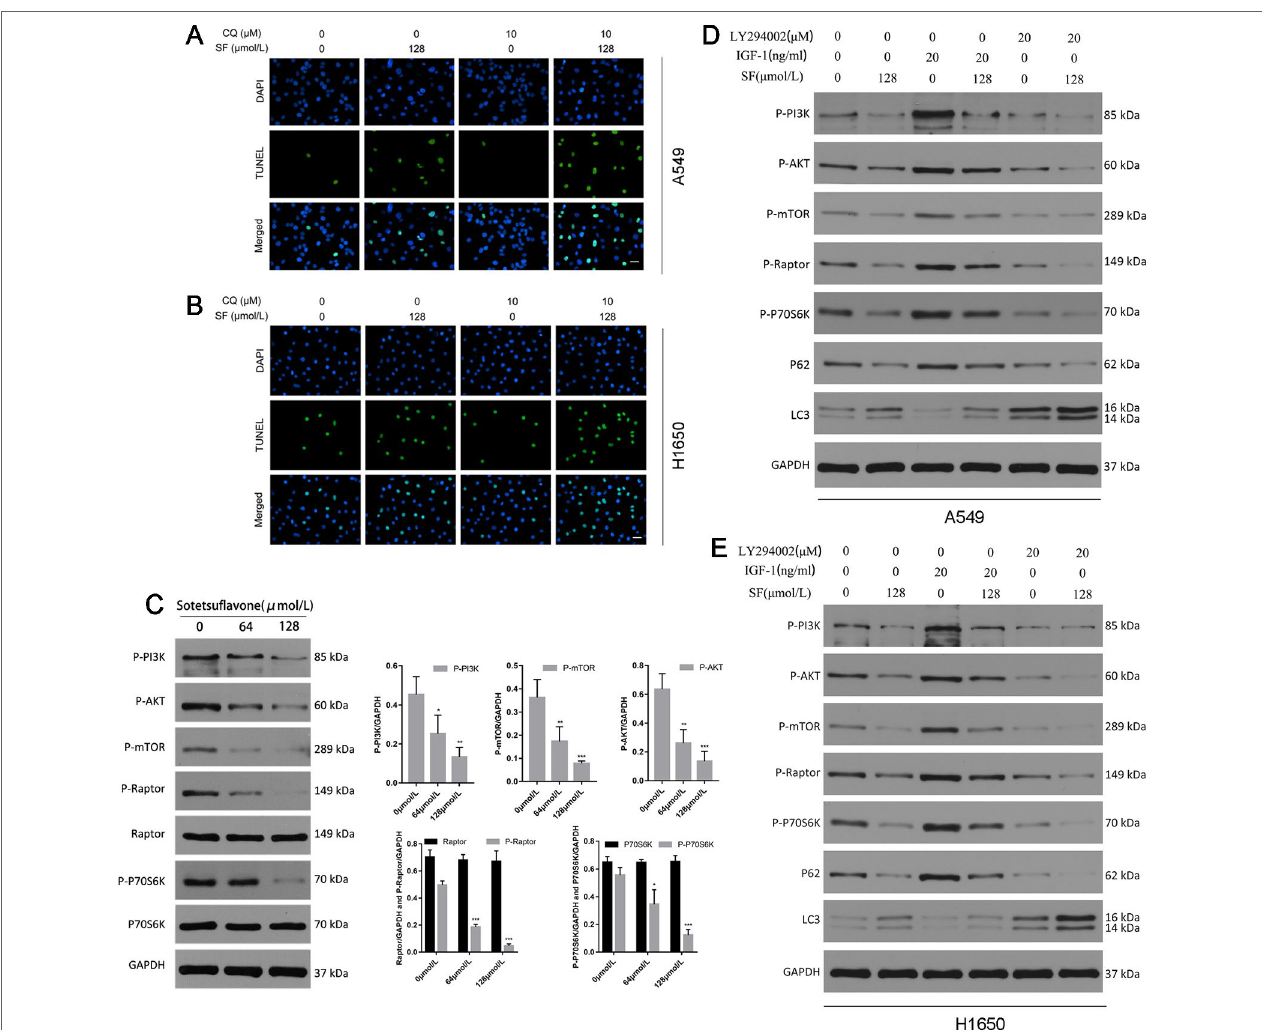
FIgURe 4 | Inhibition of autophagy promotes apoptosis of non-small cell lung cancer cells induced by sotetsuflavone. Sotetsuflavone affects autophagy of non-small cell lung cancer cells by inhibiting the PI3K/AKT/mTOR signaling pathway. (A) and (B) A549 and H1650 cells were treated with or without sotetsuflavone (128 μmol/L) in combination with CQ (10 μM) for 24 h, then a TUNEL assay was used to detect apoptotic cells. (C) The levels of expression of p-PI3K, p-Akt, p-mTOR, Raptor, p-Raptor, p70S6K, and p-p70S6K in A549 cells were evaluated by Western blotting. GAPDH was used as a loading control. Gray scale analysis was performed to determine relative proportions of p-PI3K, p-Akt, p-mTOR, p-Raptor, Raptor, p-P70S6K, and P70S6K (* p < 0.05, ** p < 0.01, *** p < 0.001 vs. control). A549 cells (D) and H1650 cells (e) were treated with or without sotetsuflavone (128 μmol/L) in combination with IGF-1 (20 ng/ml) or LY294002 (20 μM) for 24 h. Phosphorylated PI3K(p-PI3K), phosphorylated Akt(p-Akt), phosphorylated mTOR(p-mTOR), phosphorylated Raptor(p-Raptor), phosphorylated p70S6K(p-p70S6K), P62, LC3-1, and LC3-II were detected by Western